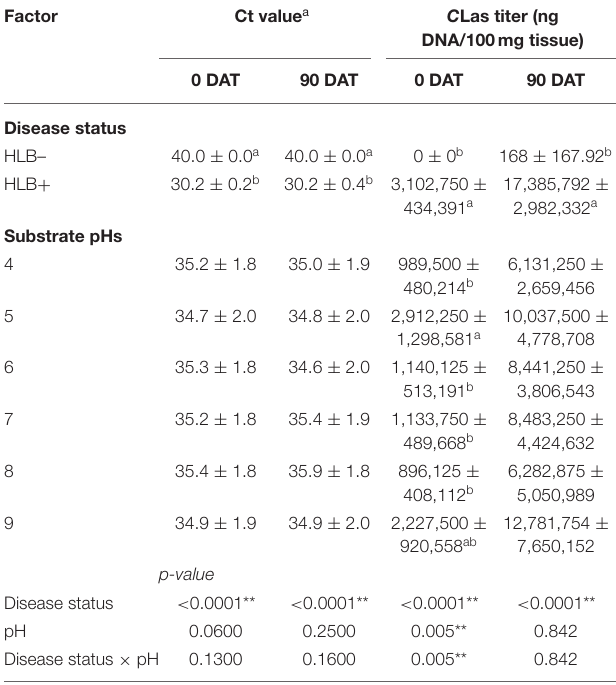
TABLE 1 | Ct value and C Las titer of “Ray Ruby” grapefruit ( C. paradisi ) on sour orange ( C. aurantium ) rootstock exposed to different HLB disease statuses [HLB-free or healthy (negative, HLB–) and HLB-affected (positive, HLB + )] under an increasing range of substrate pHs (4–9) at 0 and 90 DAT.